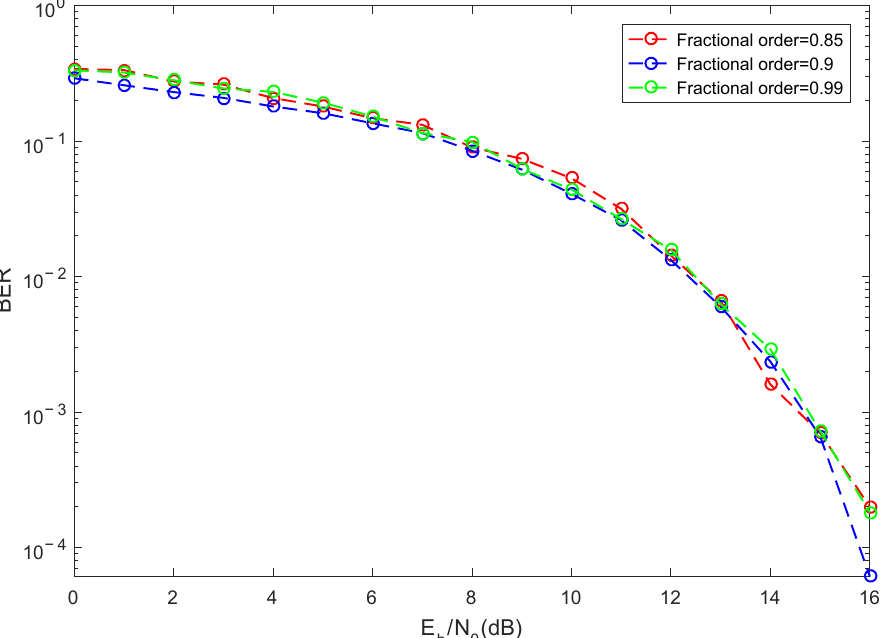
Fractional order=0.85 Fractional order=0.9 Fractional order=0.99